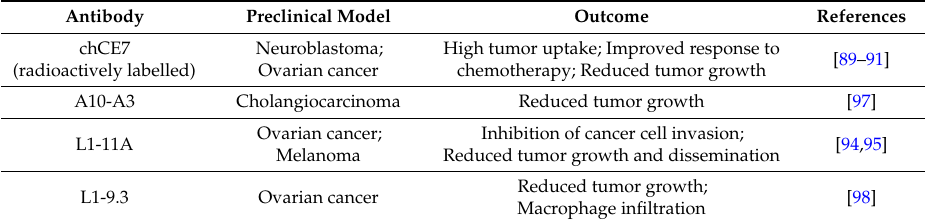
Table 1. Use of anti-L1CAM antibodies in preclinical tumor